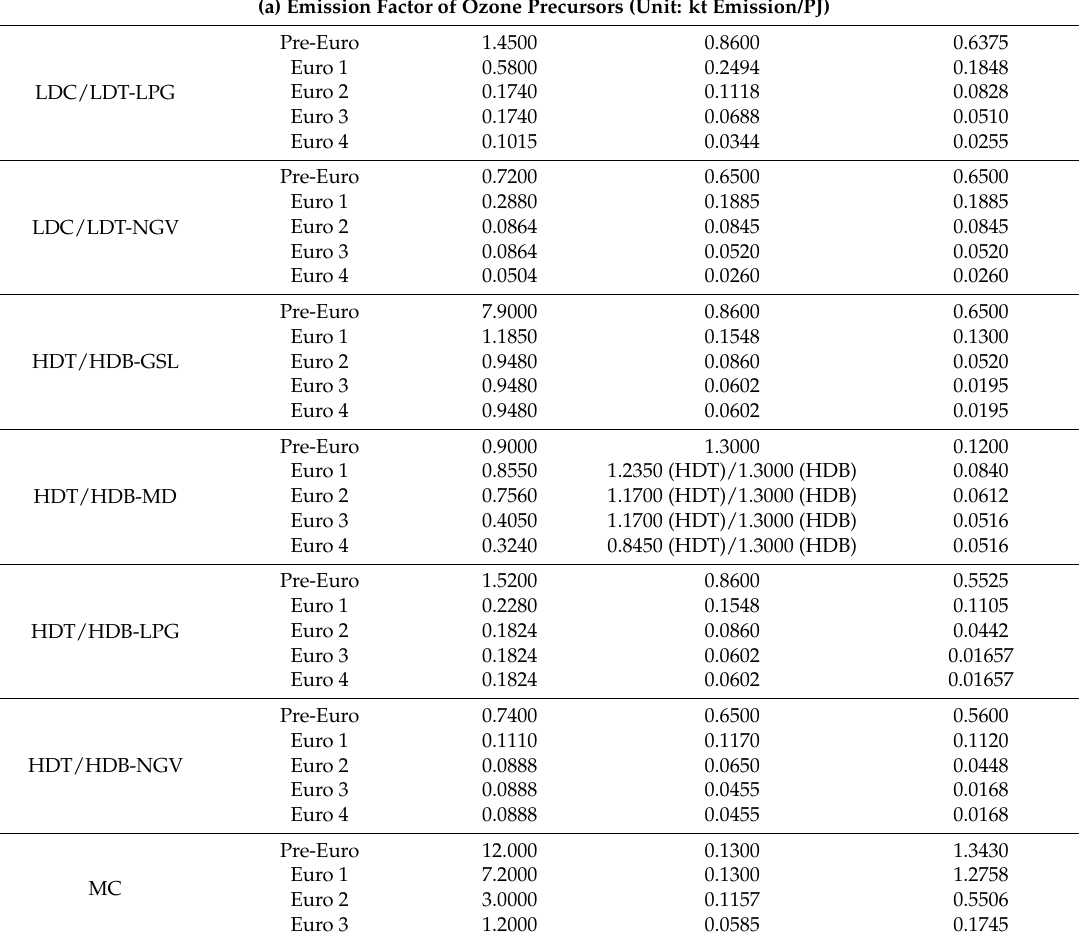
(a) Emission Factor of Ozone Precursors (Unit: kt